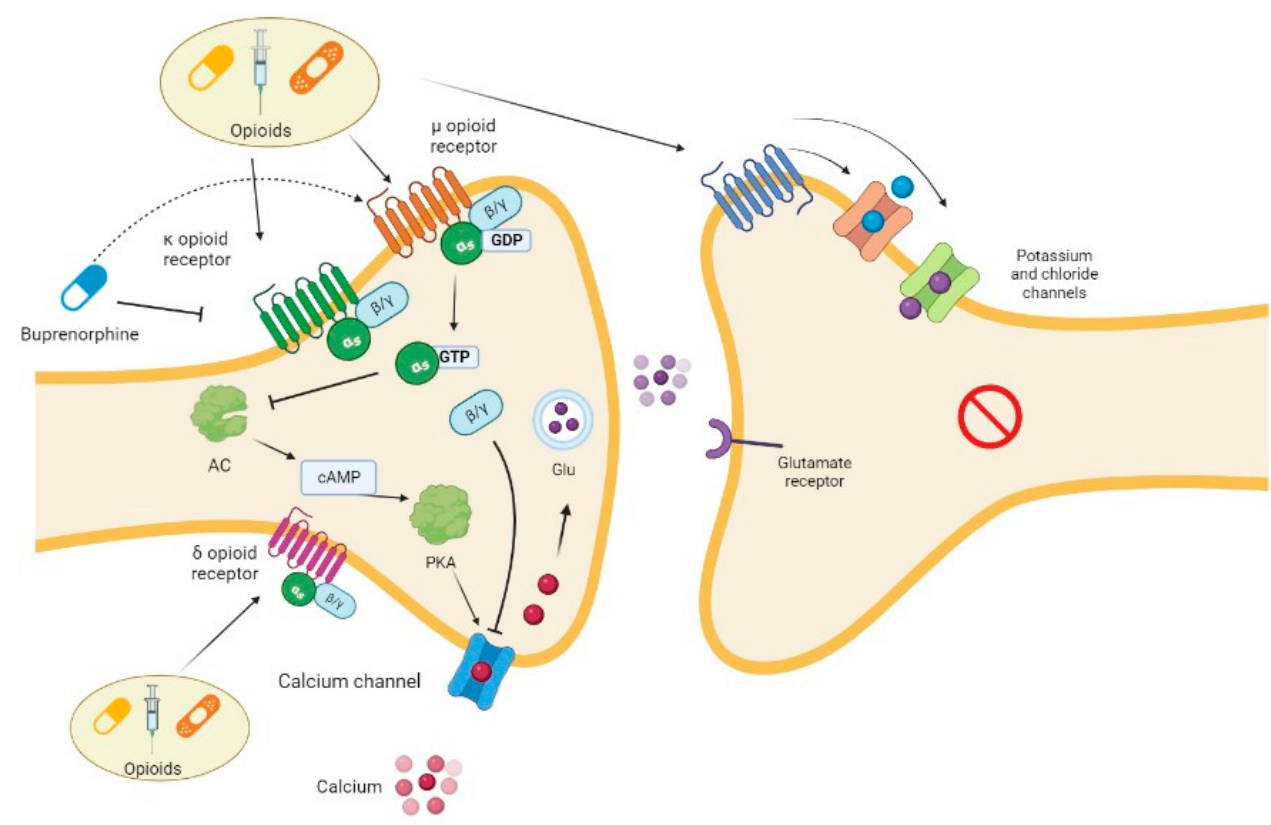
Figure 1. Opioid mechanism of action. Opioids bind to their µ , κ , and δ receptors at presynaptic level, carrying out different actions. After the interaction with a receptor, the α subunit of protein G inhibits the pathway of AC, resulting in a reduction in calcium channel activity and then the release of glutamate. The same channel is inhibited via the βγ subunit. Buprenorphine is a particular drug since it has partial agonist activity on µ receptor and antagonist activity on κ receptors. Opioids also exert stimulating activity on calcium and chloride channels, resulting in hyperpolarization at postsynaptic level. AC, adenylate cyclase; cAMP, cyclic adenosine monophosphate; GDP, guanosine diphosphate; Glu, glutamate; GTP, Guanosine-5 ′ -triphosphate; PKA, protein kinase A.